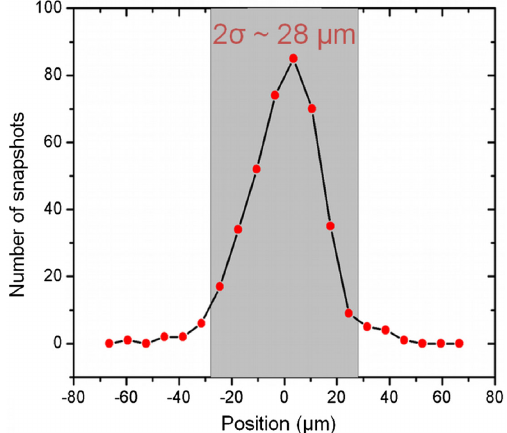
FIG. 1. (a) Photograph of the tape drive target system. (b) Schematic of the control system for the tape drive target where M 1 and M 2 represents stepper motors with I 1 and I 2 are the corresponding currents.